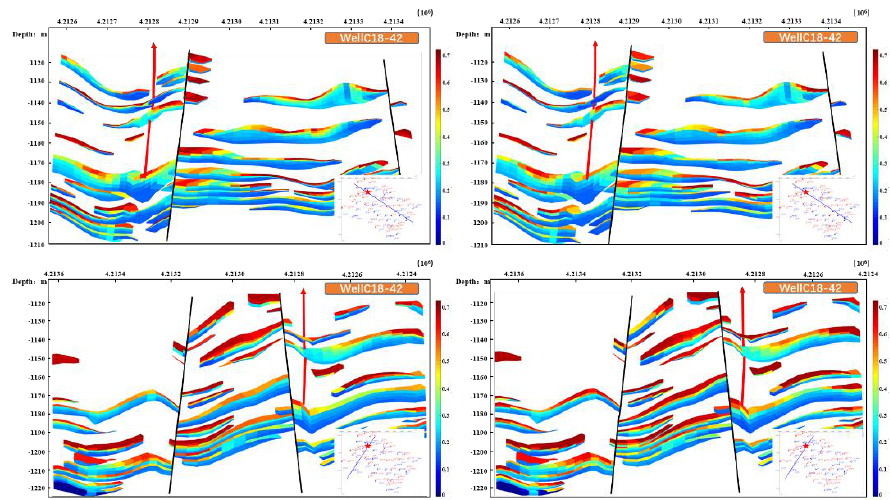
Figure 13. Cross section of remaining oil saturation of well C18-42 (the upper left one and the lower left one are the remaining oil profiles calculated by the numerical simulation method considering anisotropic relative permeability, and the upper right one and lower right one are the results of a traditional simulation).